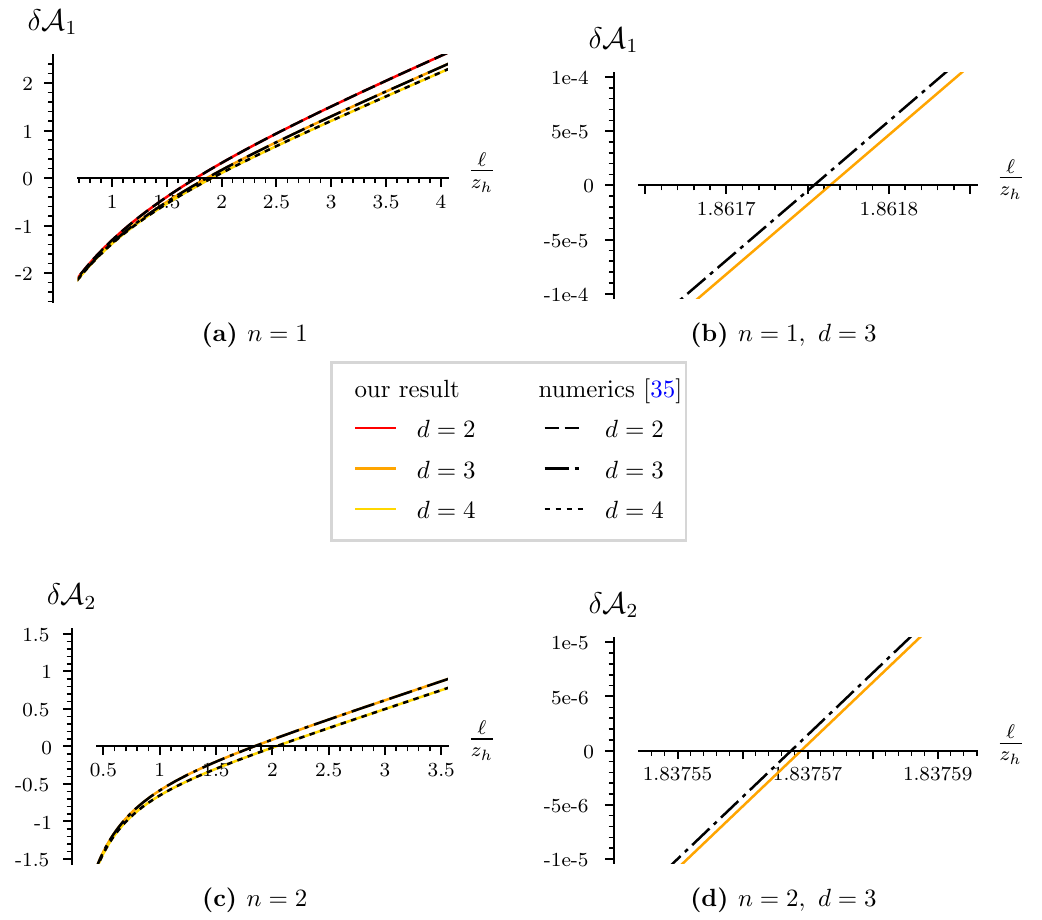
Figure 14. Comparison to numerical results of the minimal n -dimensional area. We set the AdS-radius L = 1. The results for the two-point function are shifted by ln 2 and the results for the Wilson loop are divided by twice the length 2~ ‘ to match the normalisation used for the numerical